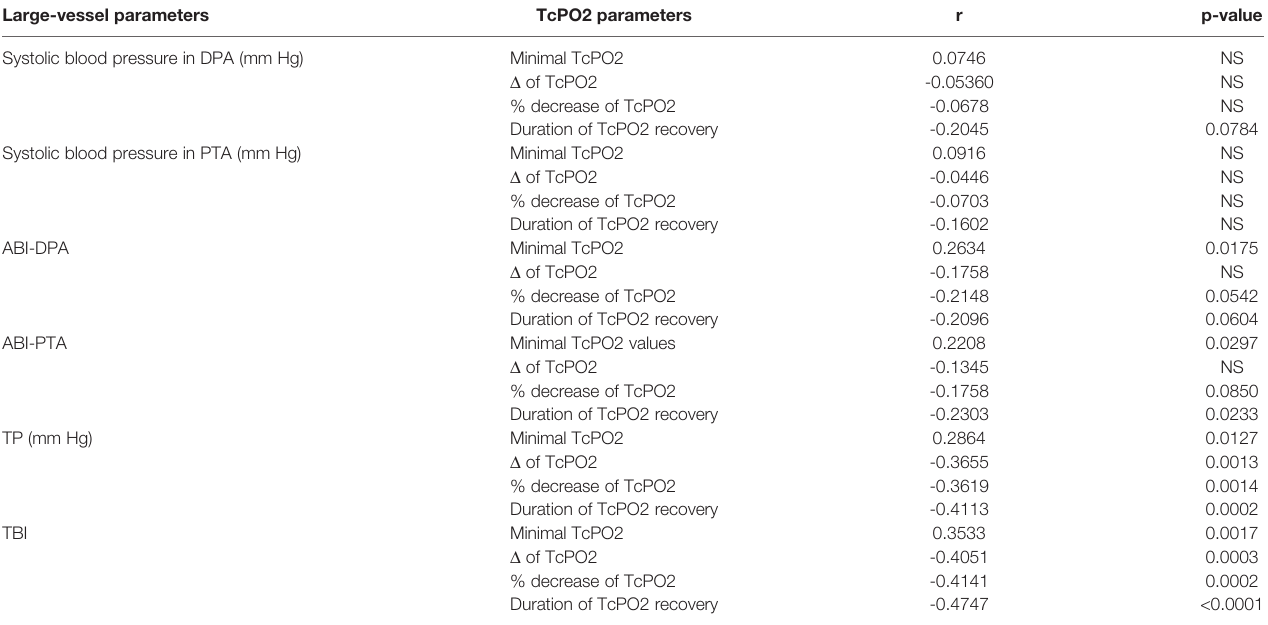
TABLE 3 | Correlation between large-vessel and TcPO2 stimulation parameters. Large-vessel